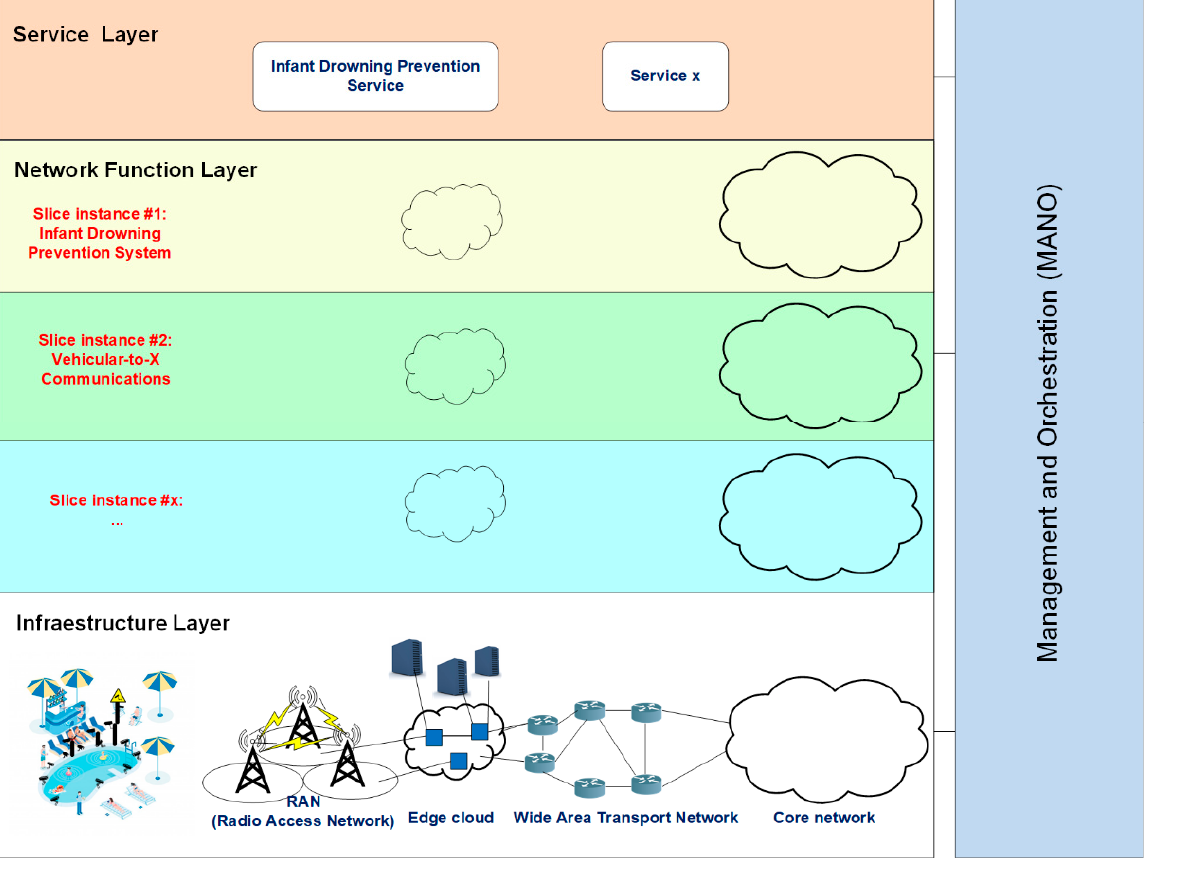
Figure 3. Network slicing architecture for child drowning prevention.